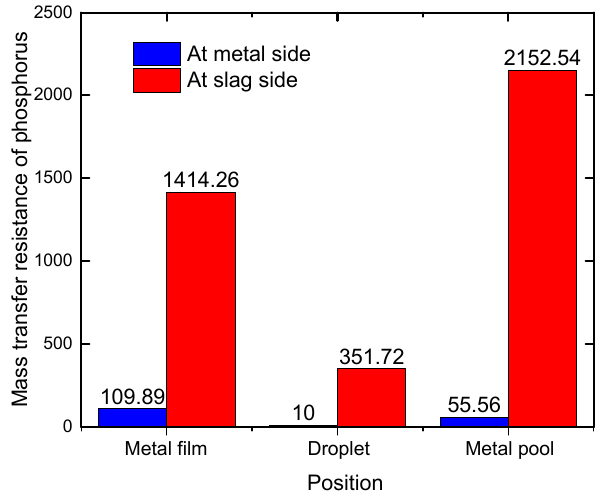
Figure 6. Comparison between calculated and measured L P.